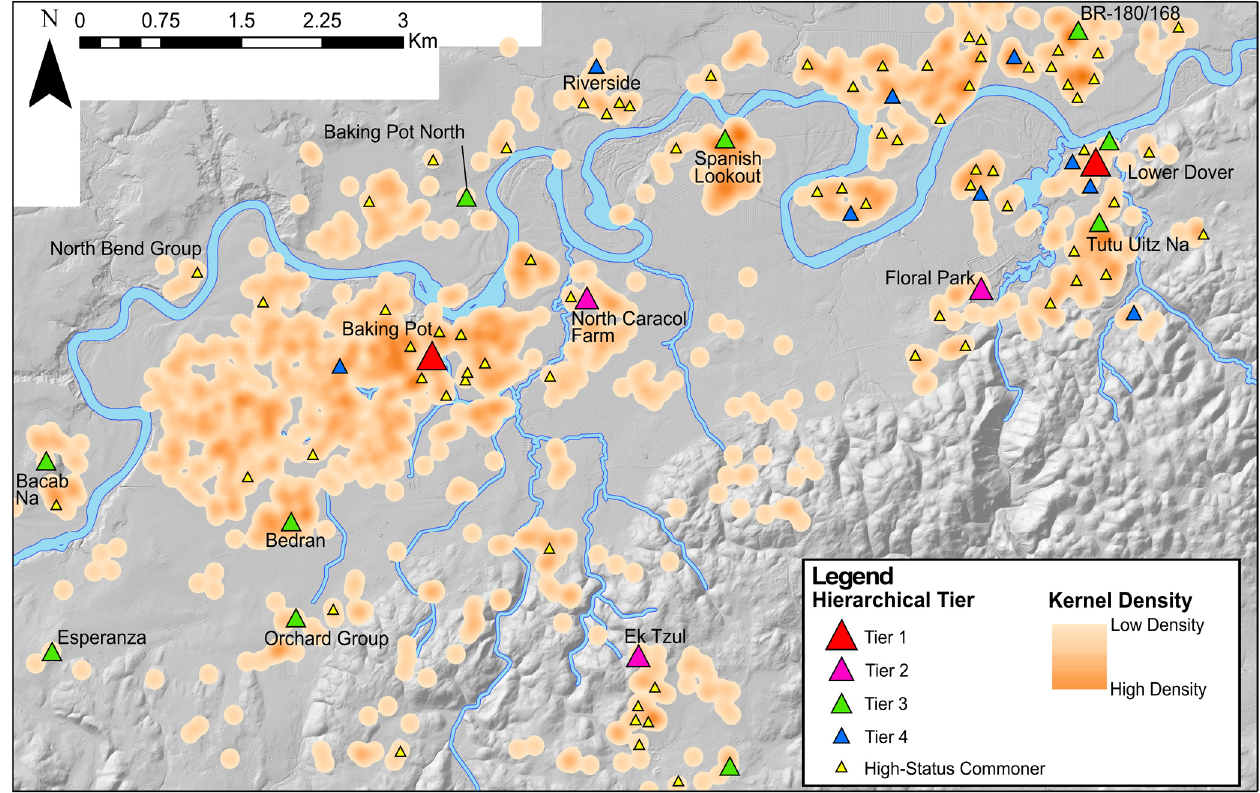
Figure 4. Kernel density map showing district level clusters at Baking Pot and Lower Dover.